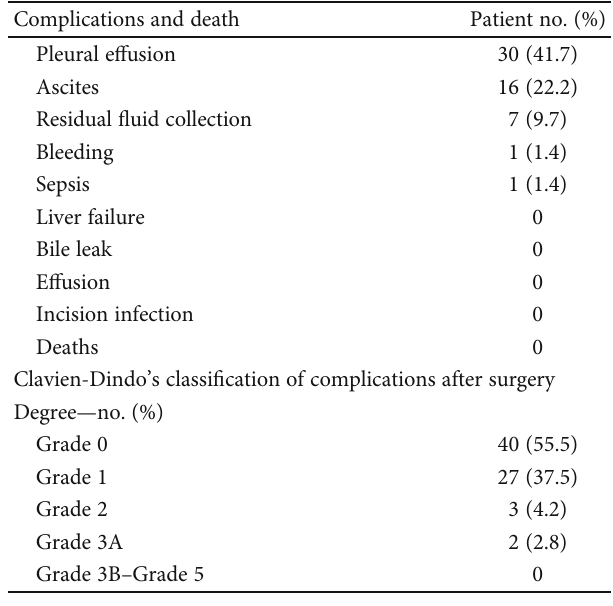
Table 5: Complications and death after